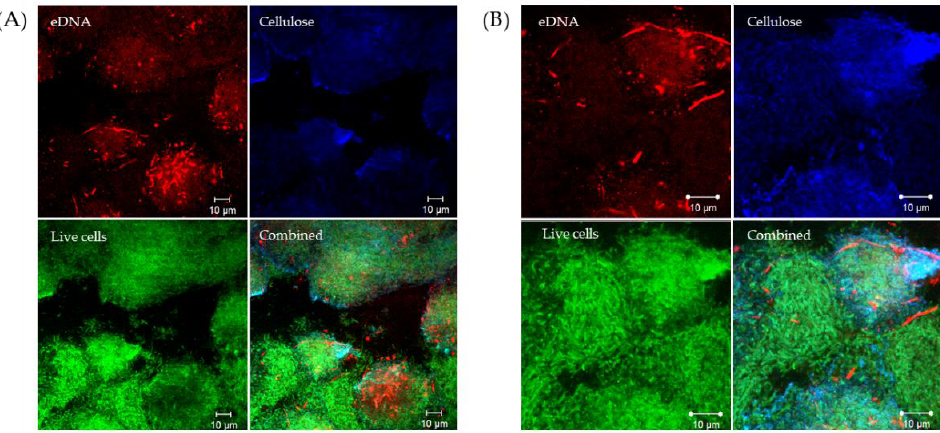
Figure 2. eDNA and cellulose accumulate above masses of cells in P. fluorescens SBW25 biofilms. Confocal laser scanning microscopy (CLSM) was used to visualize eDNA and cellulose against a backdrop of GFP-expressing metabolically active Wrinkly Spreader (WS-GFP) mutant cells in three- day-old biofilms. Shown here are single-channel and combined CLSM images of two sections of a Wrinkly Spreader biofilm ( A , B ). Propidium iodide (red channel) was used to visualize eDNA, GFP (green channel) to visualize live cells, and Calcofluor white (blue channel) to visualize cellulose, respectively, and all three channels are combined in the bottom-right image. The scale bars indicate 10 µm.